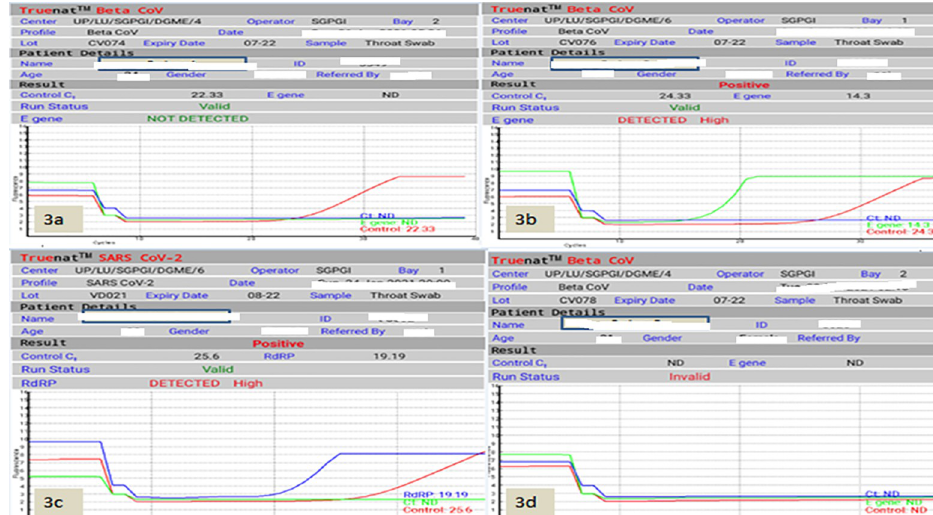
Fig 3. Heading: Shows the RTPCR graph generated by TrueNat machine. Legend: 3a shows a negative report with only fluorescence in the Control gene RNase P; 3b shows the fluorescence in the E-gene and control gene; 3c shows fluorescence above the cutoff to RdRP and control gene; 3d shows an invalid test result with no amplification in RNase gene.